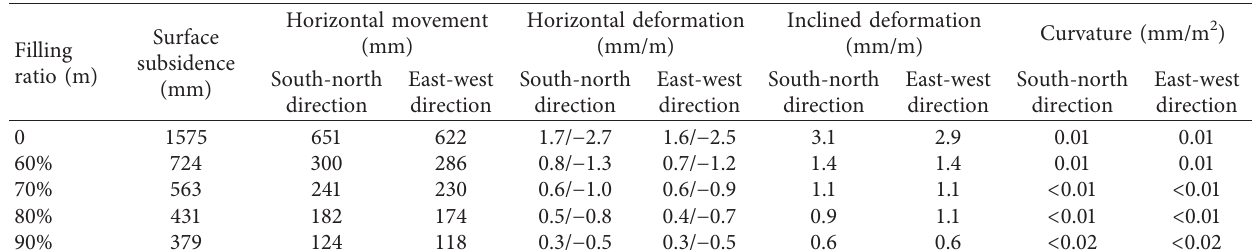
Table 4: Surface deformation characteristics affected by the filling ratio.